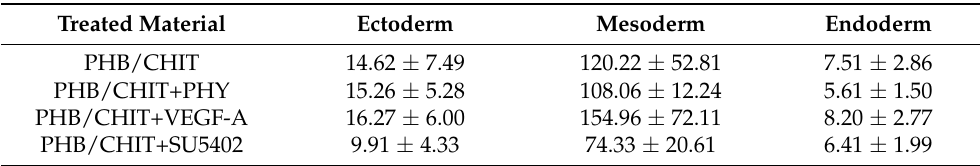
Table 4. Thickness of the CAM layers. Data are presented as a thickness of each layer in µ m ± SD of n = 3 independent experiments. Experimental groups included six samples of the scaffolds for each group.